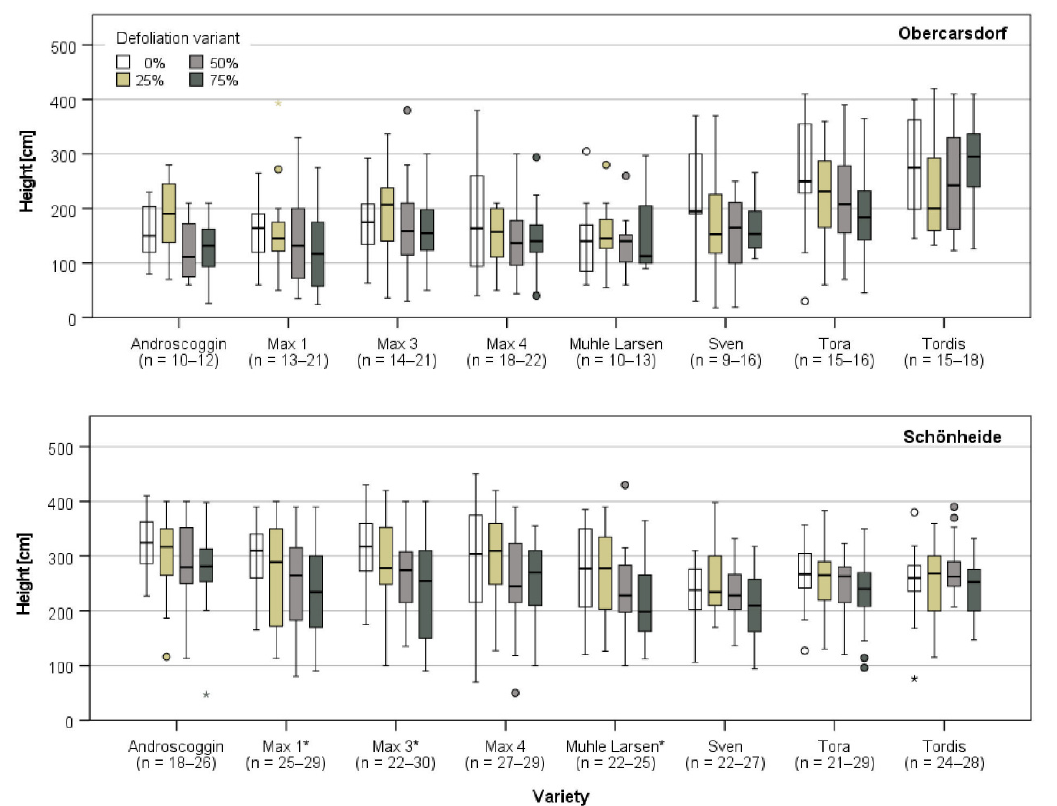
Figure 5. Height of poplar and willow varieties on the study sites in Obercarsdorf and Schönheide prior to the start of the growing season in April 2010 with regard to the defoliation variant in 2007 and 2008 (n = range of number of plants per defoliation variant, * statistically significant difference according to ANOVA). Table 10. p values of pairwise comparisons of plant heights among former defoliation variants (DVs) for both tree genera (green) as well as for all varieties with at least one significant value (orange) on the study sites in Obercarsdorf and Schönheide prior to the start of the growing season in April 2010 via Tukey HSD test (bold values indicate statistically significant differences).